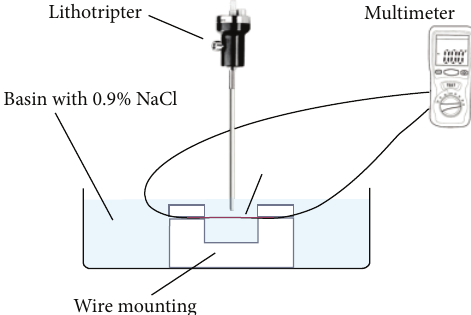
Figure 2: The schematic drawing of the experimental setup. The basket wire is fixed in a holding instrument under water. The incident angle of the lithotripter is 90 ∘ . The ohmic resistance of the basket wire is measured by an ohmmeter.